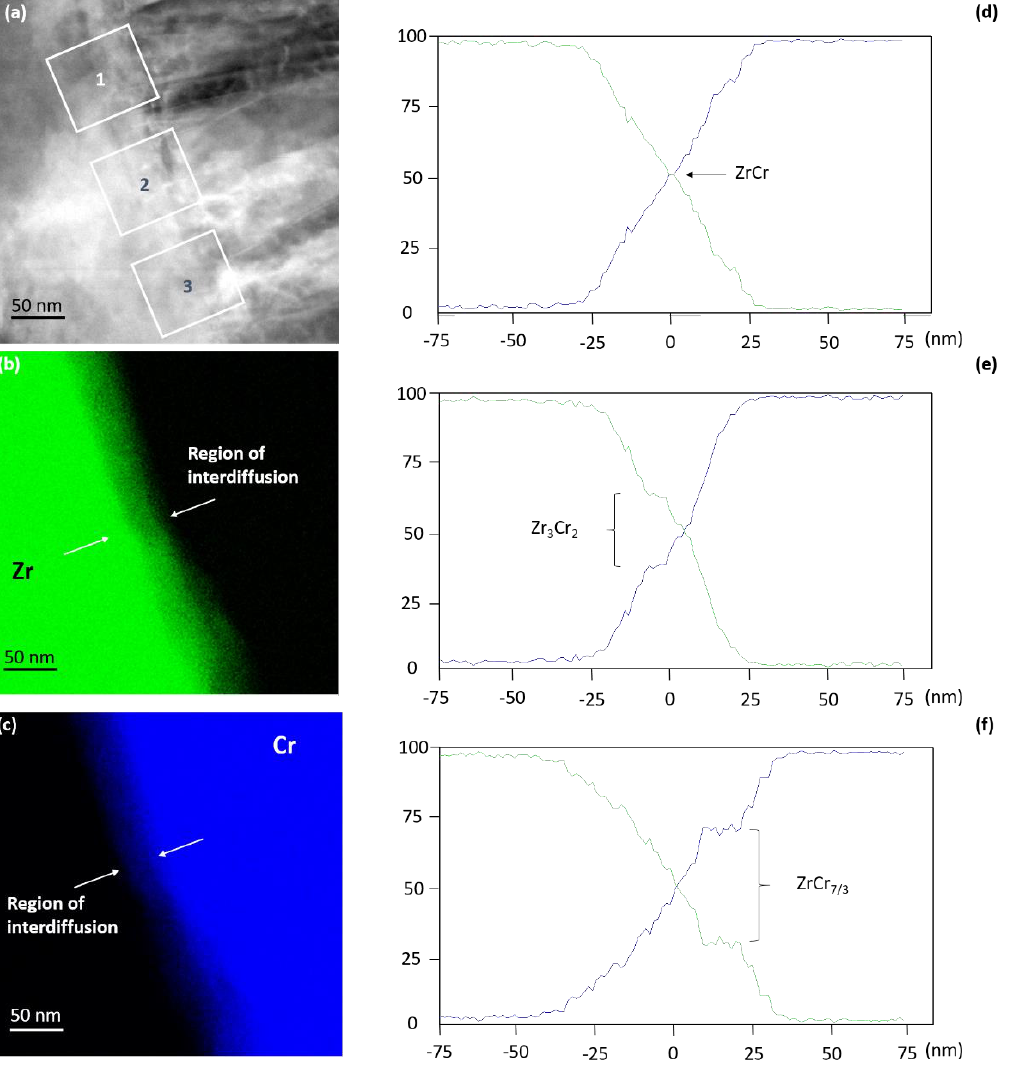
Figure 3. EDS analyses of the interface region: ( a ) STEM-ADF image, ( b ) EDS map obtained after collection of X-rays generated by emission from the energy-level shell Zr L, ( c ) EDS map obtained after collection of X-rays generated by emission from the energy-level shell Cr K, ( d ) Zr-Cr composition profile extracted from region labeled 1, ( e ) Zr-Cr composition profile extracted from region labeled 2, ( f ) Zr-Cr composition profile extracted from region labeled